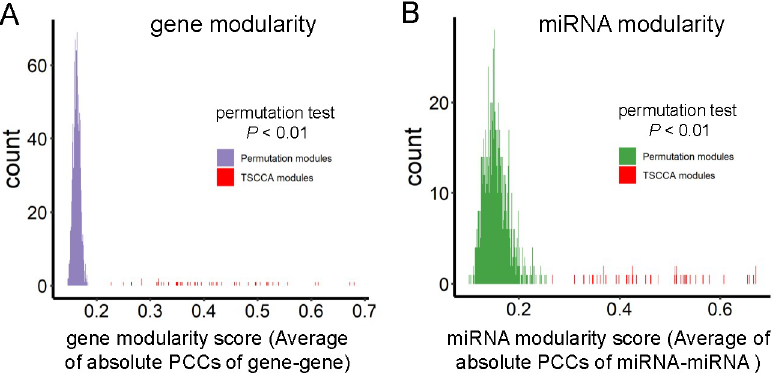
Fig 6. Statistical analysis of PCCs of module miRNAs/genes using permutation test. (A) The average of absolute gene-gene PCCs of the genes within each module (Permutation test P < 0.01). (B) The same results about miRNAs.